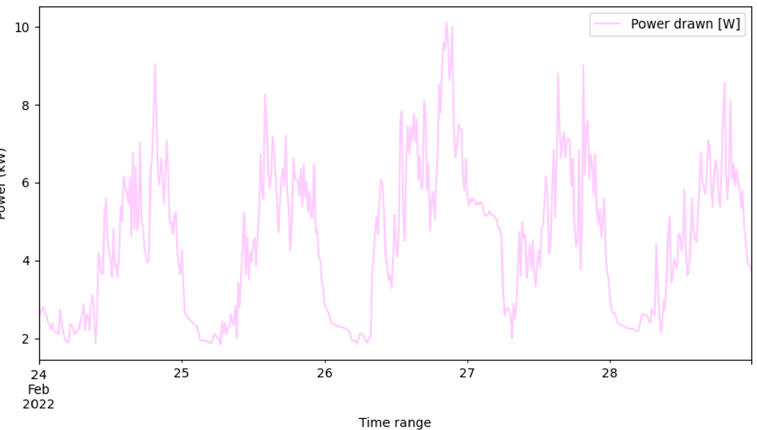
Figure 13. Measured power (22–28 February 2022).